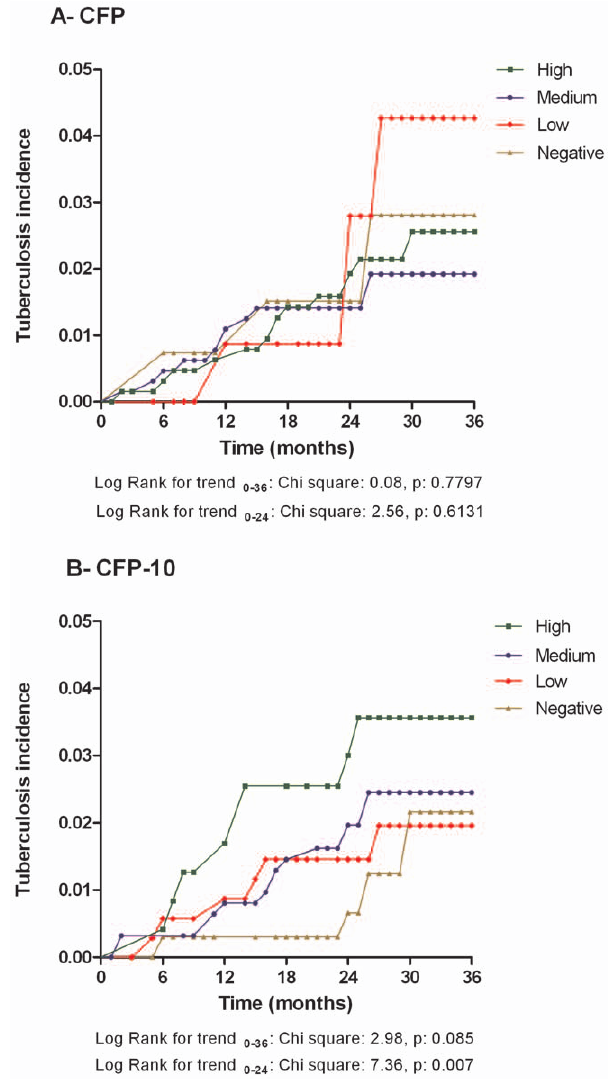
Figure 4. Hazard of TB development according to IFN c production. Hazard levels of tuberculosis development taking the modified version of IFN c production categories proposed by Andersen et al [11] as baseline predictors of disease. Negative: , 22pg/mL, Low: 22–99 pg/mL Medium: 100–999 pg/mL, High: $ 1000 pg/mL. HHCs: Household Contacts SP: Source